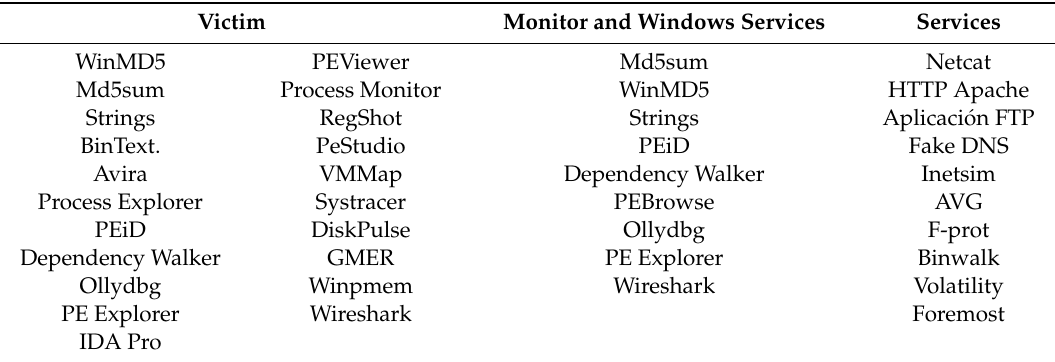
Table 6. Tools used in the analysis